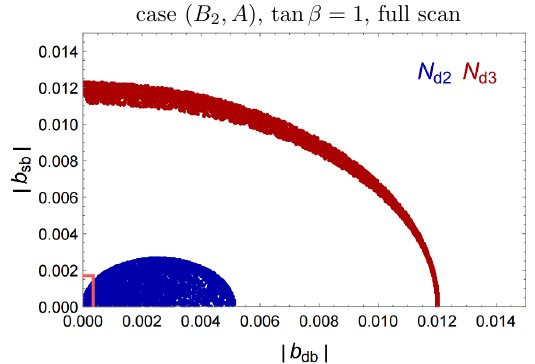
Figure 10 . The values of | b db | and | b sb | for N d 2 and N d 3 in a full scan of case ( B 2 , A ) .